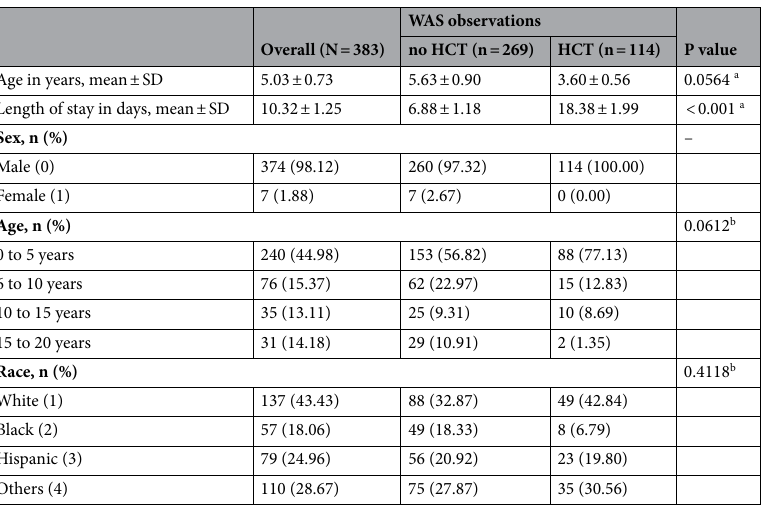
Table 1. Demographic characteristics of wiskott-aldrich syndrome patients. HCT—hematopoietic stem cell transplantation, SD—standard deviation. a Two-tailed independent sample t-test. b Rao-Scott adjustment for chi-square test.